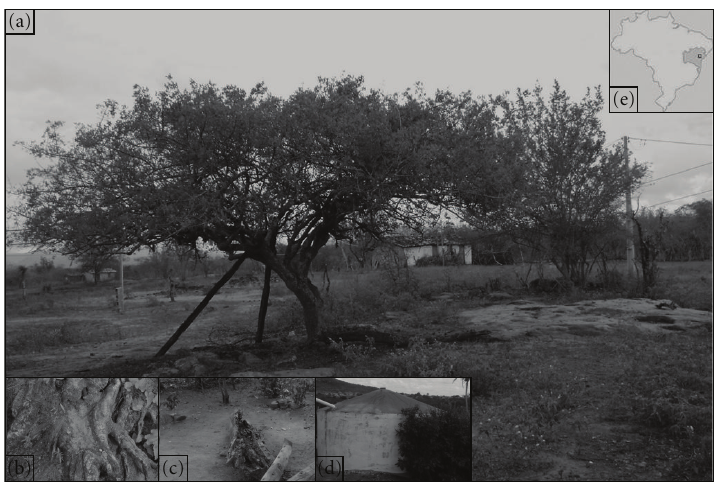
Figure 1: Location of Cavunge district and positive microhabitats (a) Typical scenario from Cavunge: trees with exposed roots along with exposed rocks (b) soil accumulated between exposed roots of a Spondias tuberosa tree (c) a fallen trunk (d) a water tank. (e) location of Cavunge